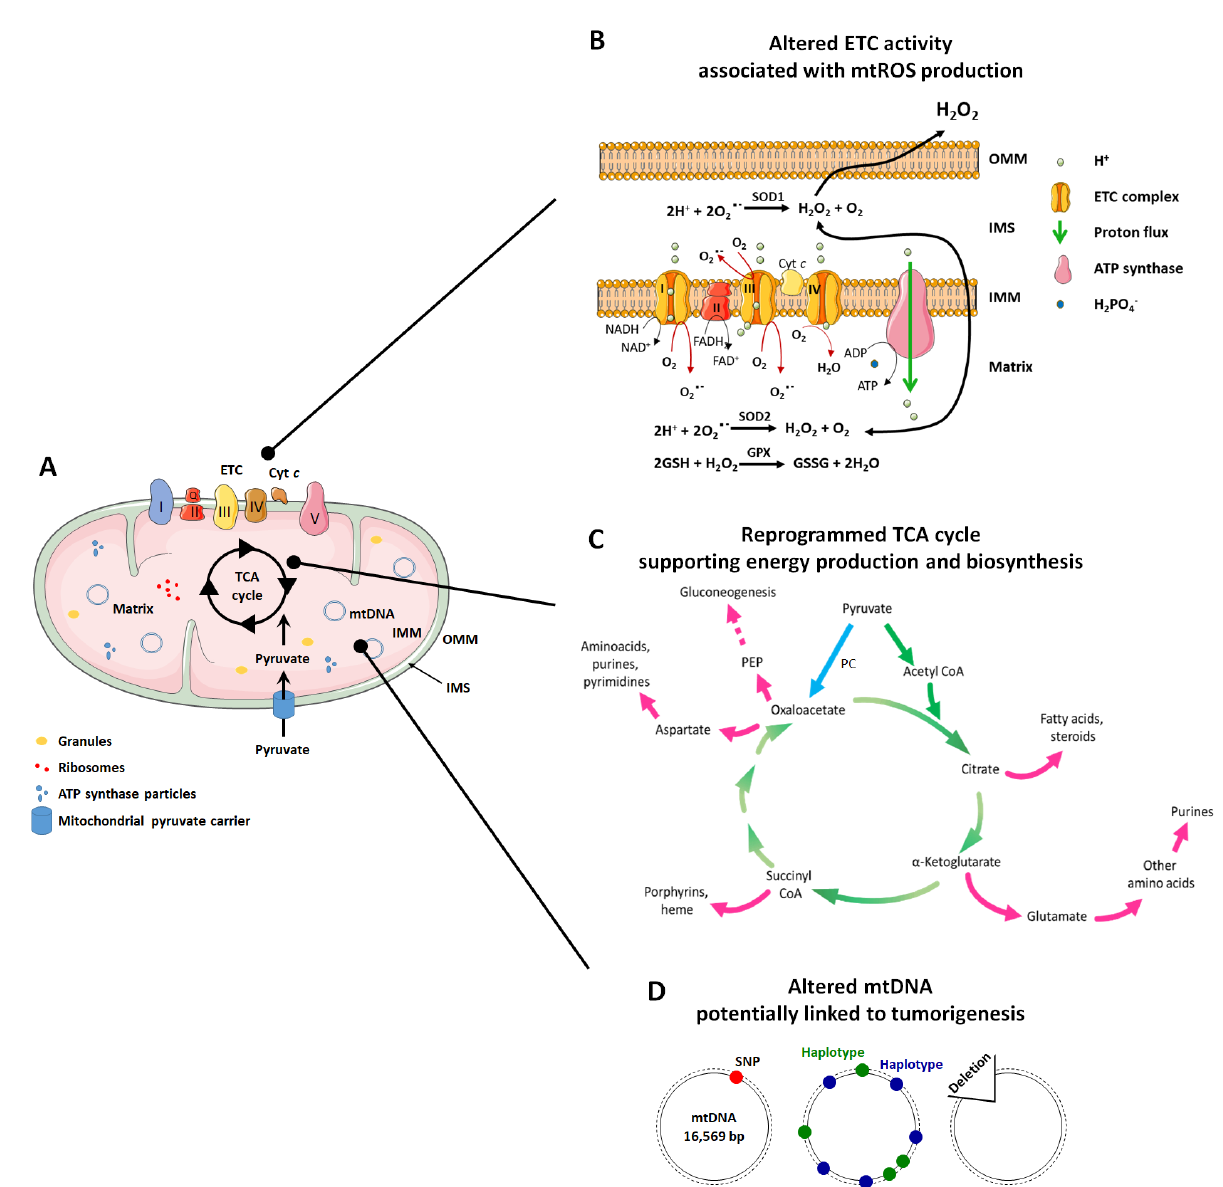
FIGURE 1: Cancer is associated with alterations of mitochondrial functions. (A) Mitochondria in normal and in cancer cells are composed of three compartments. They are separated from the cell cytosol by an outer membrane (OMM), an intermembrane space (IMS), and an inner membrane (IMM) that forms invaginations called "crests". The IMM delimitates the mitochondrial matrix, a gelatinous material containing mitochondrial DNA (mtDNA), granules, ribosomes and ATP synthase particles. The mitochondrial matrix hosts the tricarboxylic acid (TCA) cycle, while the IMM hosts the electron transport chain (ETC). (B) In highly metabolically active or hypoxic cancer cells much more than in normal cells under normal conditions, electrons escape during mitochondrial electron transport at Complexes I and III generate superoxide (O 2- ) from oxygen (O 2 ) in both the IMS and the matrix. O 2- is immediately dismutated to H 2 O 2 either spontaneously or under the catalysis of superoxide dismutases SOD1 (in the IMS) or SOD2 (in the matrix). In the matrix, H 2 O 2 can be neutralized by glutathione (GSH). It can also signal to the cytosol. (C) In cancer cells, the TCA cycle not only serve to produce reducing equivalents to fuel the ETC (green arrows), but also to generate biosynthetic intermediates that are necessary for cell proliferation (pink arrows). The most important anaplerotic reaction pro- duces oxaloacetate directly from pyruvate, and is catalyzed by pyruvate carboxylase (PC) (blue arrow). Oxaloacetate can further be con- verted to phosphoenolpyruvate (PEP) by PEP carboxykinase (PC), contributing to gluconeogenesis. (D) Mitochondrial DNA (mtDNA) varia- tions, including single nucleotide polymorphisms (SNPs), maternally inherited haplotypes and deletions have been studied for their associa- tion with cancer. Among these, only large mtDNA deletions seem to be associated with malignancies. Cyt c - cytochrome c ; Gpx - glutathione peroxidase; Q - coenzyme